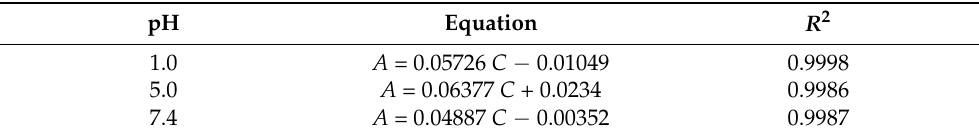
Table 4. Correlation equation and coefficient ( R 2 ) under different pH